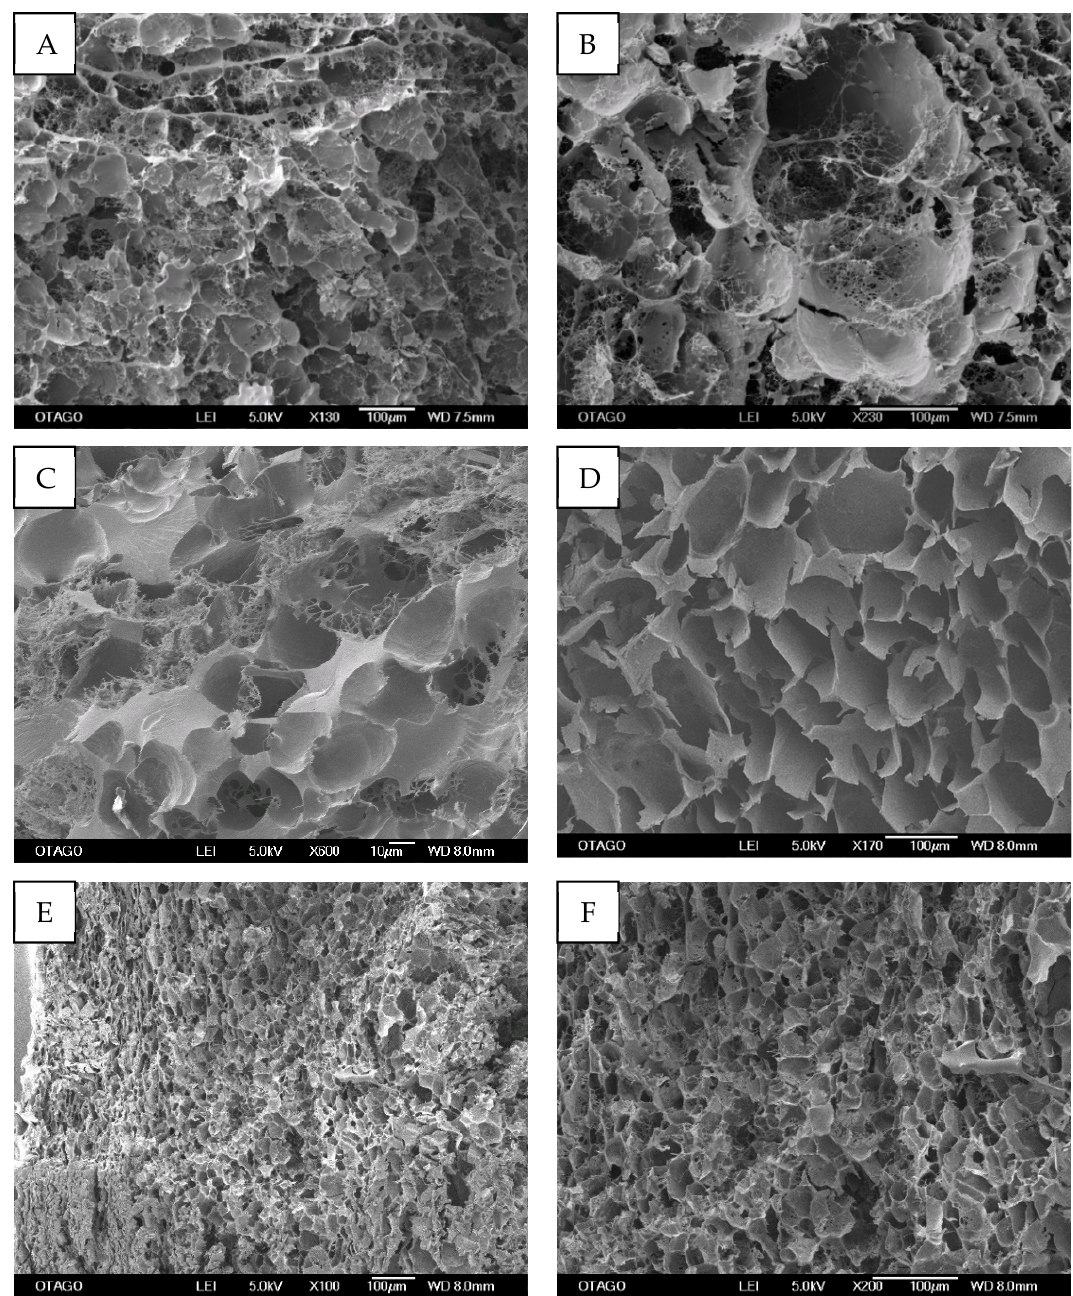
Figure 4. Cross-sections of intact Ly-PRF demonstrated a highly porous structure with a mixture of homogenous and heterogenous pore sizes. (SEM; original magnification: ( A ) ×130, ( B ) ×230, ( C ) ×600, ( D ) ×170, ( E ) ×100 and ( F ) ×200). (Bar = 100 µm) Images ( A , B ) from Donor 1, images ( C , D ) from Donor 2 and images ( E , F ) from Donor 3.